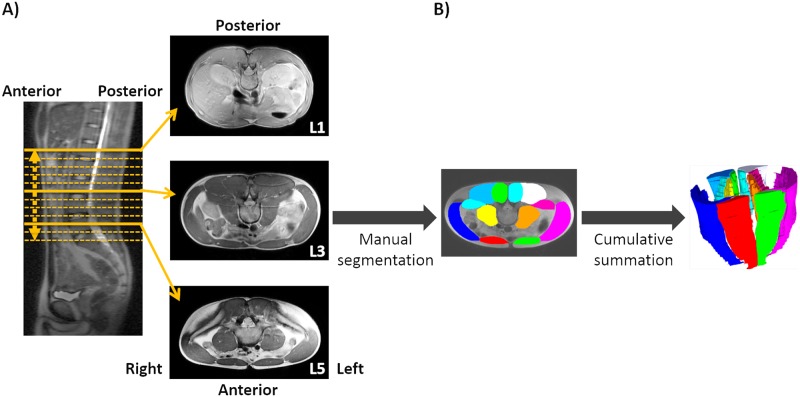
A) Transverse magnetic resonance images of the trunk; B) Manual segmentation of the trunk muscles and cumulative summation of the cross-sectional area.